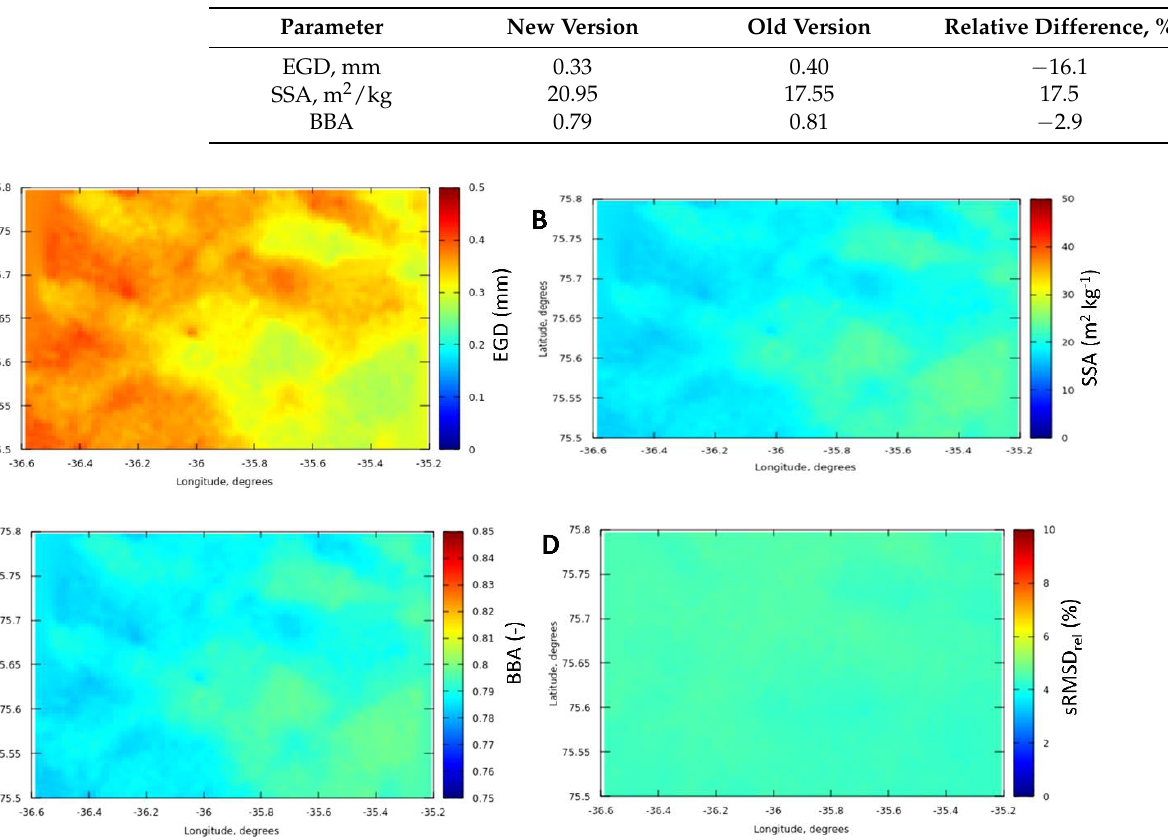
Figure 9. The retrieved snow parameters in the vicinity of the EGP site (75.6247N, 35.9748W) on the 2 August 2019: EGD ( A ), SSA ( B ) and BBA ( C ), as well as the retrieval quality metrics: sRMSD rel ( N = 16), the per-pixel relative spectral RMSD between observed and retrieved TOA reflectance ( D ) and Δ TOC , the per-pixel relative difference between the retrieved total ozone column and the value from ECMWF provided with the OLCI files ( E ). 5. Conclusions This work aimed to present the updated version of the Snow and ICE (SICE-2022) retrieval algorithm based on OLCI Copernicus S-3 observations. The algorithm is based on the asymptotic radiative transfer theory, which provides accurate results as compared to the numerical solutions of the integro-differential radiative transfer equation [7] . The technique can be applied to various optical instruments operating in the visible and near IR regions of the electromagnetic spectrum. The example of retrievals using the Multi- spectral Imager on board Sentinel-2 is given by Kokhanovsky et al. [63] . The retrievals of spectral and broadband albedo highly relevant to climate change studies [1]. They have been validated using ground-based observations both for polluted and clean snow cases. Generally, the accuracy of observations is higher for clean snow and clean atmosphere. The errors of retrievals increase for polluted snow and also for the case of overlying at- mosphere with a large load of aerosol particles. The snow grain size retrievals have not been validated. However, the retrieved SICE grain size is close to that derived by the pre- vious version of the code. The validation results for the grain size for the previous version of the code have been presented in a separate study by Vandecrux et al. [2]. The multi-